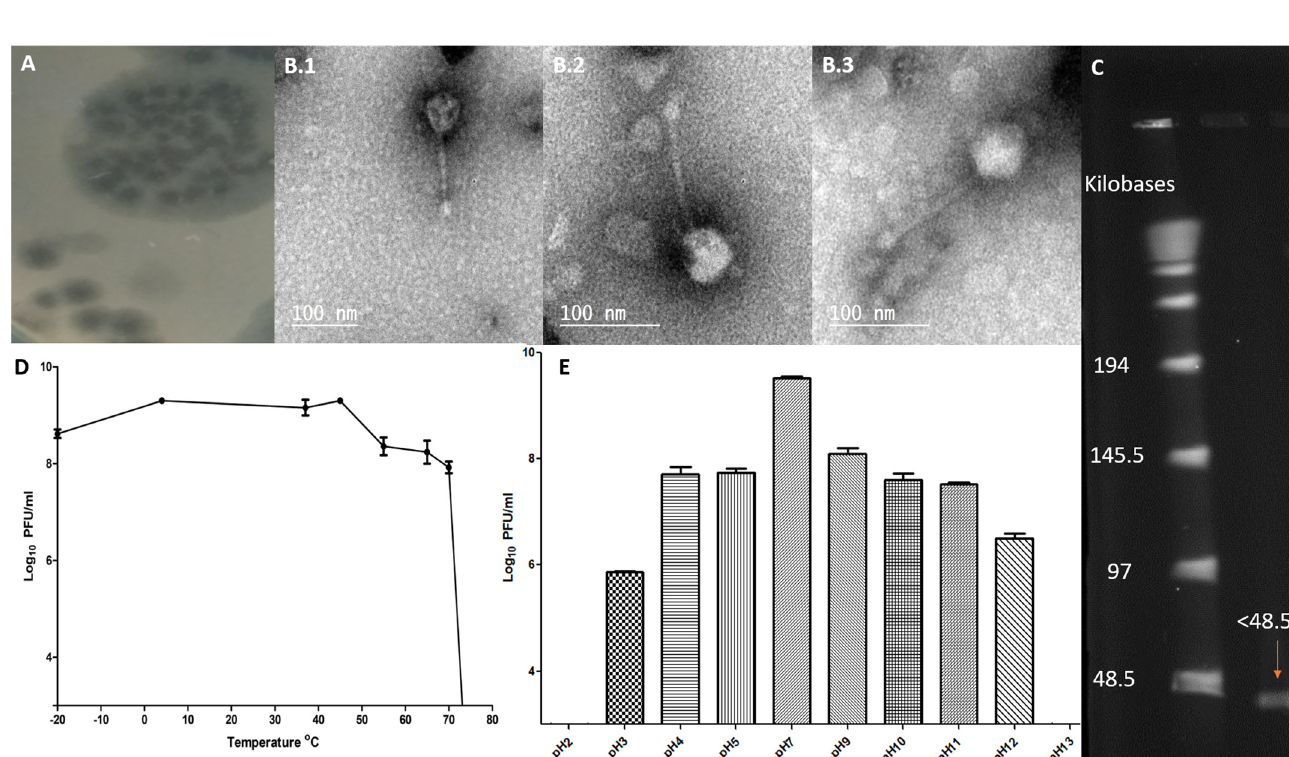
Figure 1. represents phage characterization. ( A ) The morphology of plaques on a plate containing bacterial overlay; ( B.1 – B.3 ) Different images for the same phage illustrating its morphology with scale bar of 100 nm; and ( C ) The pulsed-field gel electrophoreses (PFGE) for phage ZCSE6, where the orange arrow indicates the position of the genome band on the agarose. The color contrast was enhanced by using Snapseed v2.20.2. ( D ) Phage stability against temperatures. ( E ) The sensitivity of phage ZCSE6 against the various pH levels.